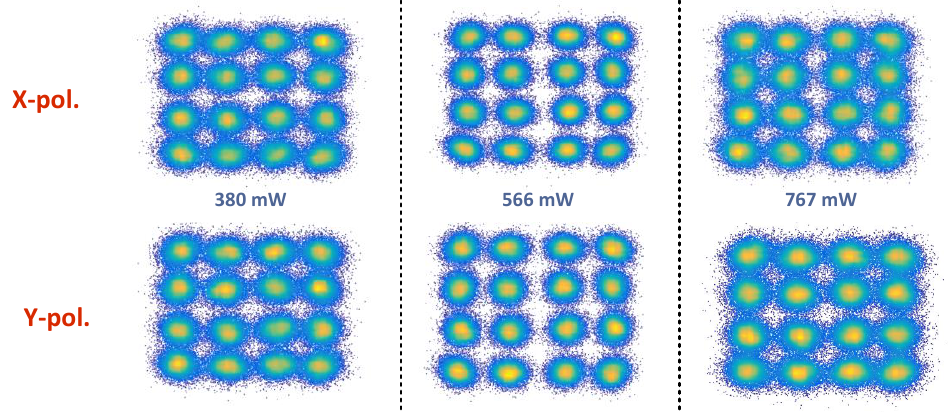
Figure 5. Constellations of DP-16QAM versus pump power for bidirectional pumping scheme for launched signal power of 5 dBm.